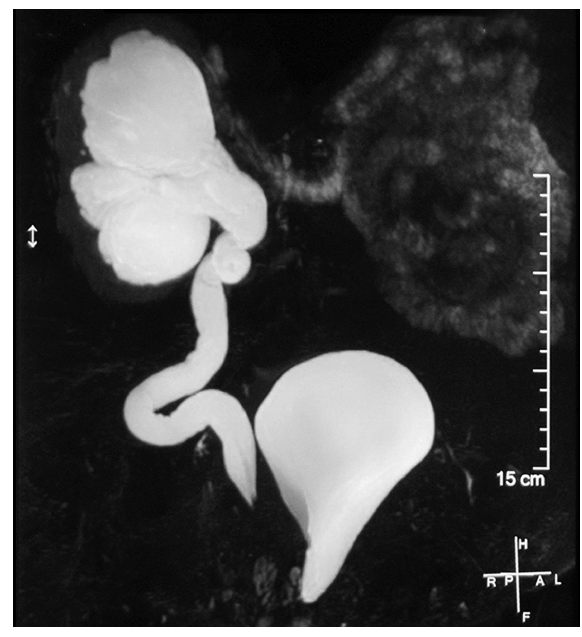
Figure 7. Contrast MRI showing pear-shaped bladder with right side solitary functioning kidney with gross HUN.